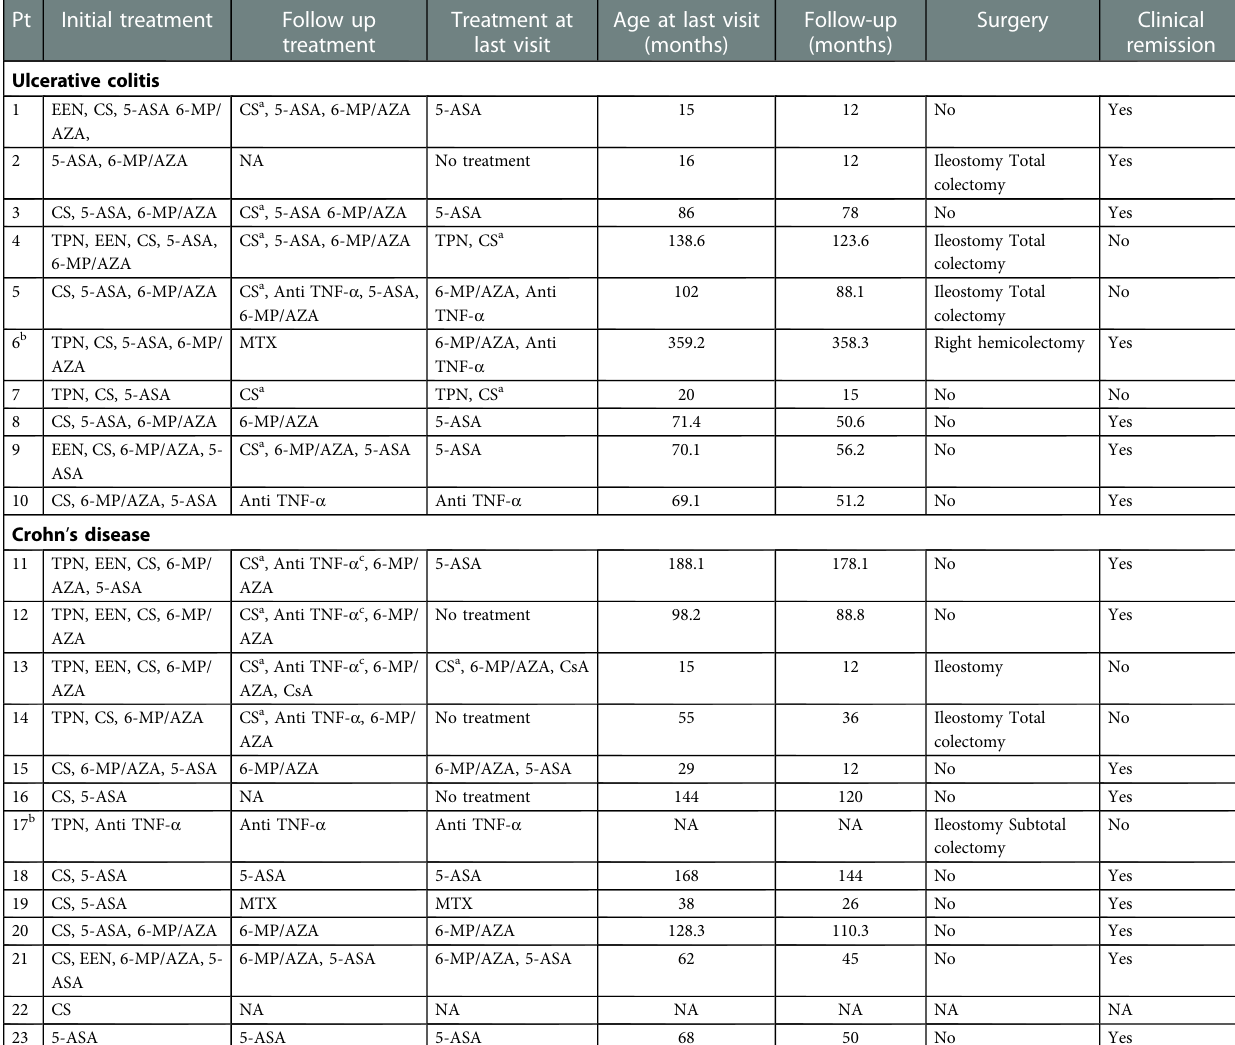
TABLE 3 Treatment during follow-up and clinical state at last follow-up of patients with IO-IBD. Pt Initial treatment Follow up